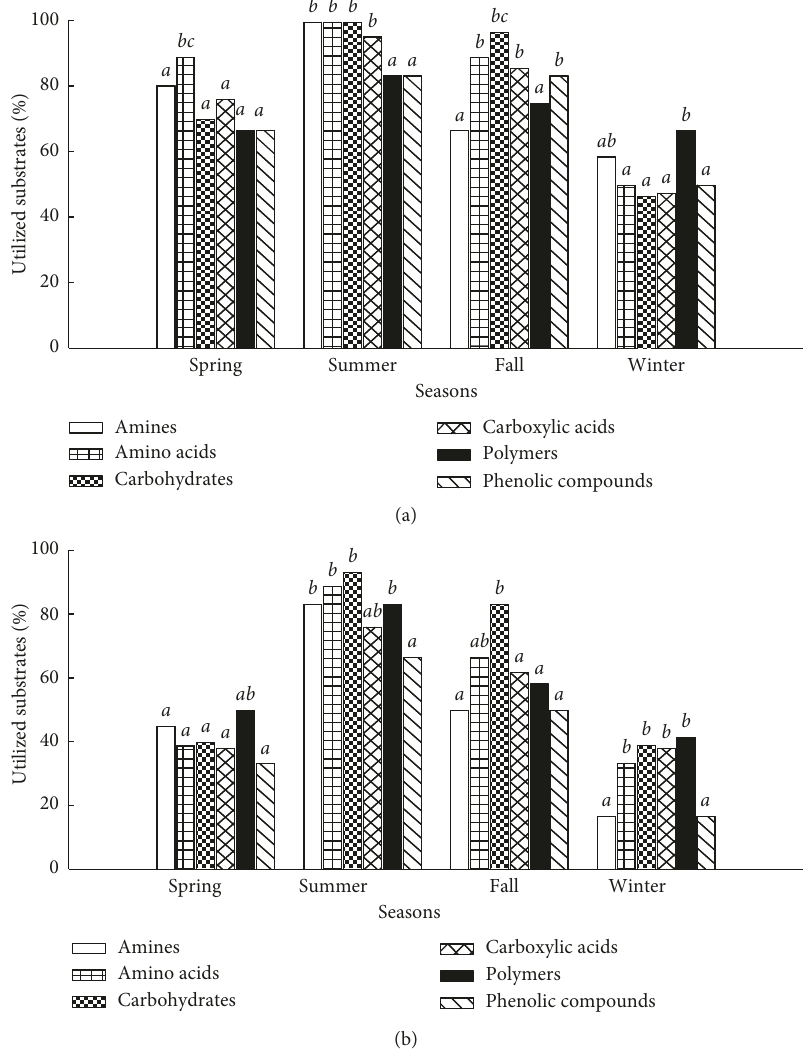
Figure 5: Percent of positive substrates separated into substrate categories for (a) river and (b) lake sediment samples at different